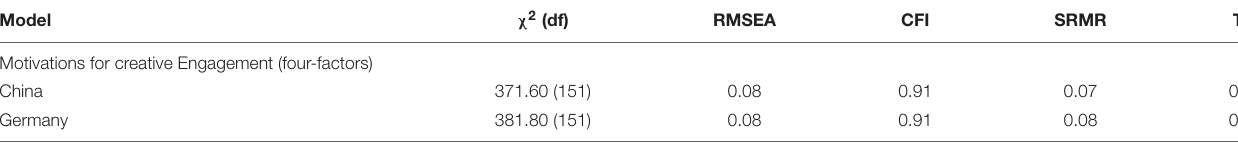
TABLE 2.2 | CFA results for the pooled sample of motivations for creative engagement during lockdown based on a split sample. Model χ 2 (df) RMSEA CFI SRMR TLI